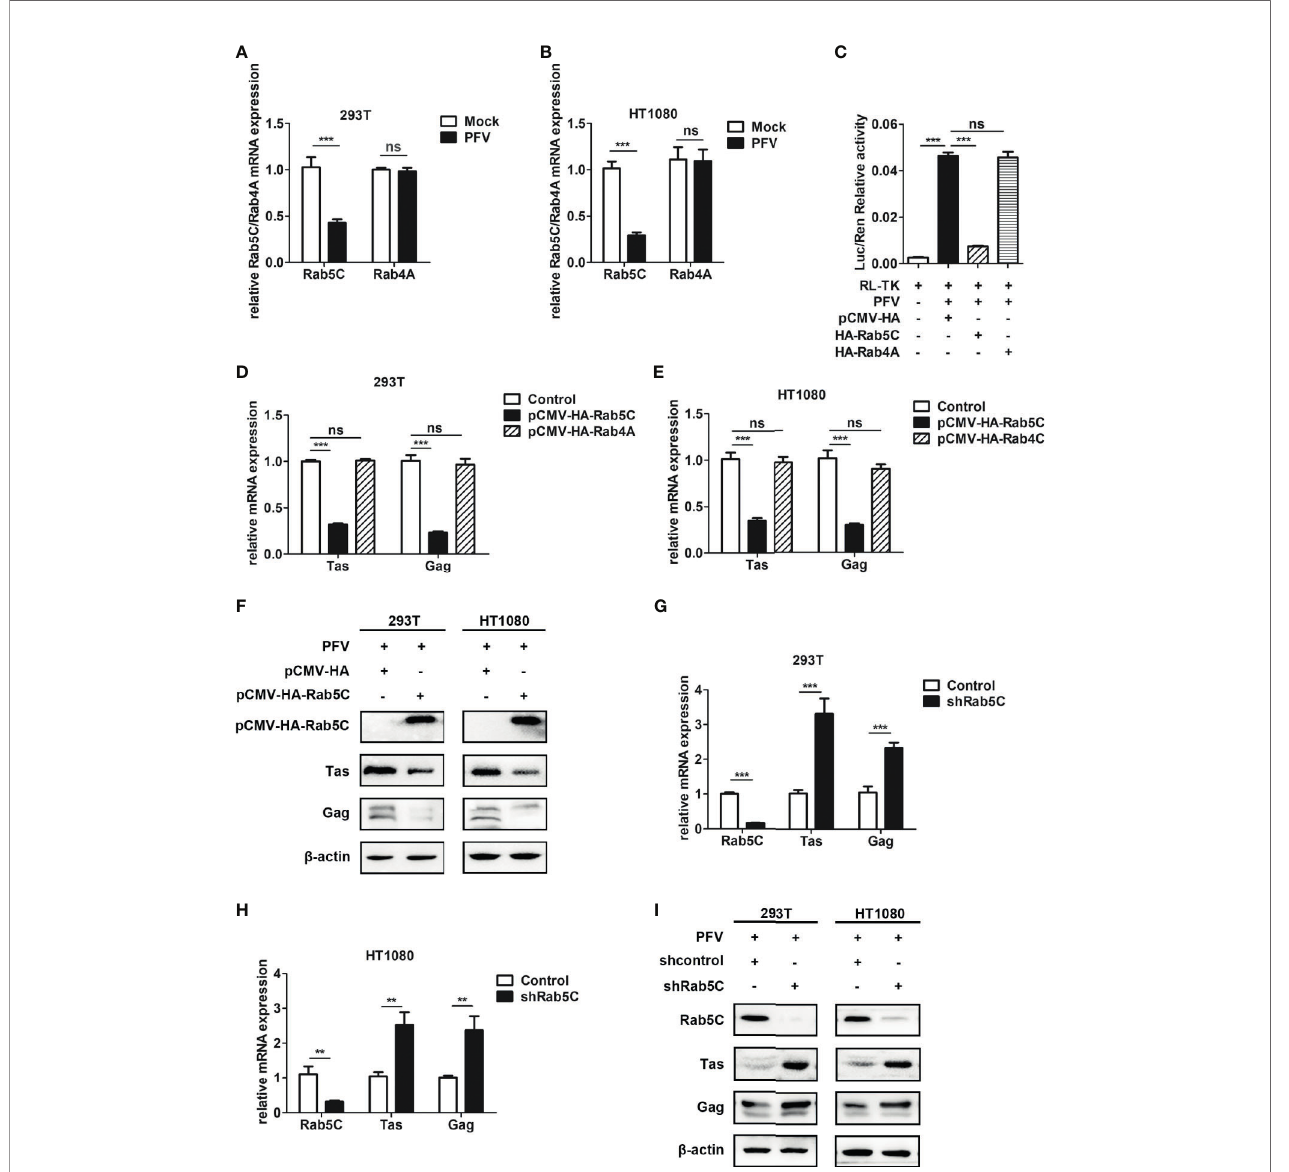
FIGURE 6 | Rab5C, rather than Rab4A, inhibits the replication of PFV. (A, B) Gene expression of Rab5C and Rab4A after PFV infection. After infection with PFV for 48 h, the mRNA expression of Rab5C and Rab4A in HEK293T and HT1080 cells was detected by qPCR (*** p < 0.001 and ns , no signi fi cance). (C) The relative viral load in the presence or absence of overexpressed Rab5C or Rab4A was analyzed in PFV indicator cell line. RL-TK (1.5 m g) was transfected as an internal control. (D, E) pCMV-HA-Rab5C or pCMV-HA-Rab4A and pCMV-HA (as an empty control) were transfected into HEK293T and HT1080 cells for 24 h. After transfection, cells were infected with PFV (MOI = 0.5) for 48 h. The mRNA expression of PFV Tas and Gag was detected by qPCR (*** p < 0.001). (F) pCMV-HA-Rab5C and pCMV-HA (as an empty control) were transfected into HEK293T and HT1080 cells for 24h. After transfection, cells were infected with PFV (MOI = 0.5) for 48 h. The protein expression of Tas and Gag were detected by western blotting. (G, H) The speci fi c shRNA of Rab5C or shControl (as a negative control) was transfected into HEK293T and HT1080 cells for 24 h to knockdown the expression of Rab5C and then the cells were infected with PFV (MOI = 0.5) for 48 h. The mRNA expression of PFV Tas and Gag was detected by qPCR (** p < 0.01 and *** p < 0.001). (I) The speci fi c shRNA of Rab5C or shControl (as a negative control) was transfected into HEK293T and HT1080 cells for 24 h to knock down the expression of Rab5C, and then the cells were infected with PFV (MOI = 0.5) for 48 h. The protein expression of Tas and Gag were detected by western change signi fi cantly compared with the control vector (pCMV- expression levels of Tas (2.9-fold) and Gag (3.4-fold) were also HA) group ( Figures 6D, E , p < 0.001). The protein expression of reduced in the Rab5C group compared to the control vector Tas and Gag in HEK293T and HT1080 cells was also detected by (pCMV-HA) group ( Figure 6E , p < 0.001). However, the western bolt analysis, and it was signi fi cantly down-regulated expression of Tas and Gag in Rab4A transfected cells did not